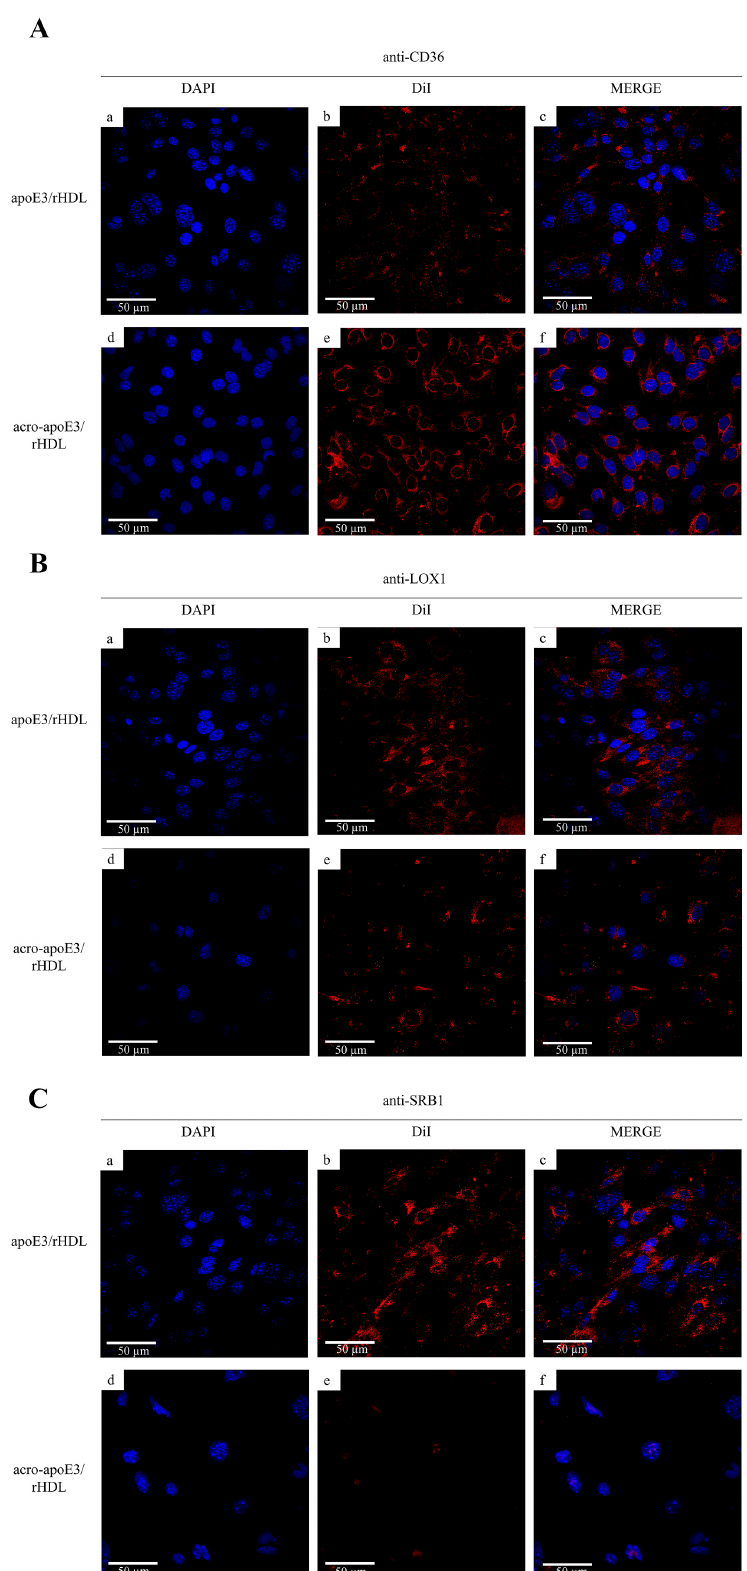
Figure 7. Uptake of apoE3 / rHDL and acro-apoE3 / rHDL in the presence of anti-CD36, anti-LOX1 or anti-SRB1 antibody. Uptake experiments were carried out for 2 h at 37 ◦ C with 3 µ g / mL apoE3 / rHDL ( a – c ) or acro-apoE3 / rHDL ( d – f ) in the presence of 100 µ g anti-CD36 ( A ), anti-LOX1 ( B ) or anti-SRB1 ( C ) antibody. The panels show fluorescence of DAPI (a,d), DiI (b,e), and Merge